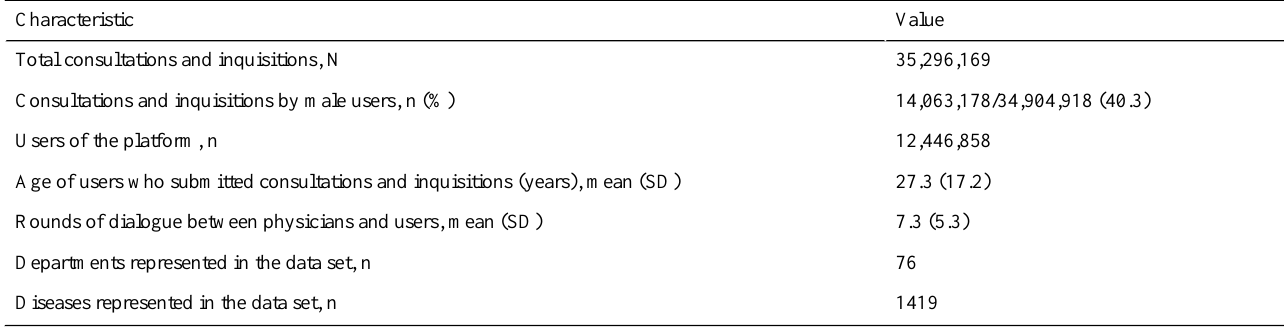
Table 2. Characteristics of the current data set.